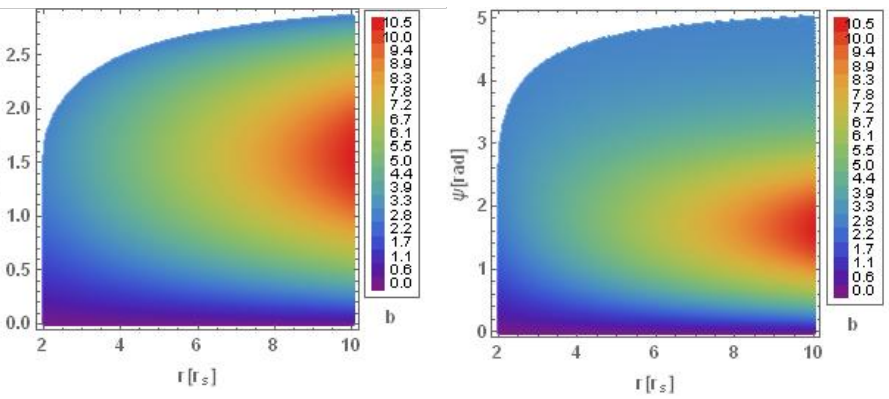
Figure 4. Relations between the parameteres ( R , Ψ , b , α ). The two figures shows the distribution in the r − α and r − Ψ plane, respectively. The colors are associated with the parameter b . These plots were made with 500 values for R and Ψ